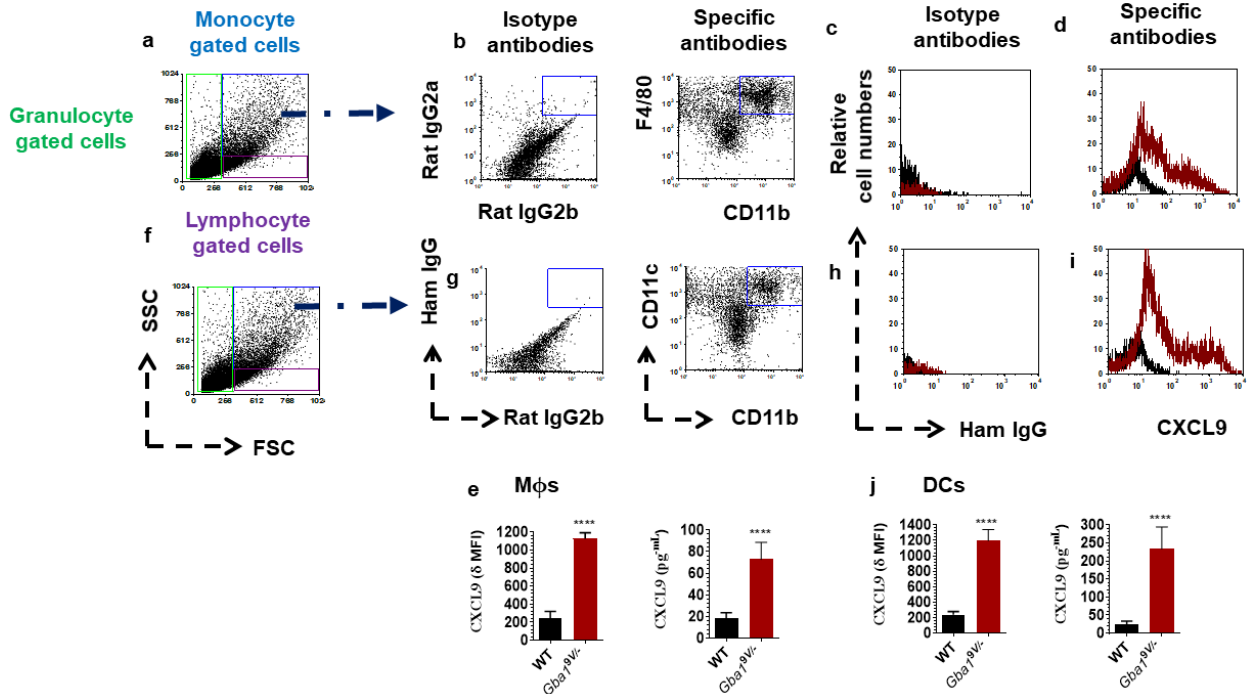
Figure 1. Immune phagocytes that cause increased amounts of CXCL9 in Gba1 9V/- mouse tissues. CXCL9 amounts in mon- ocyte gated F4/80 hi CD11b + M ɸ s ( a – e ) and CD11c hi CD11b + DCs ( f – j ) from lung of strain-matched Gba1 9V/- and WT mice ( n = 5/group). Delta Mean Fluorescence Intensity ( δ MFI): CXCL9 MFI—isotype MFI. In the histograms of isotypes ( c – h ), specific antibodies ( d – i ), and the bar diagrams, the black lines/columns correspond to WT and the maroon lines/columns to Gba1 9V/- cell. Values in d-h are the means ± SD. and asterisks show significant differences between WT and Gba1 9V/- mice (**** p < 0.0001). Three independent experiments were conducted, and groups were compared using student’s t -tests.